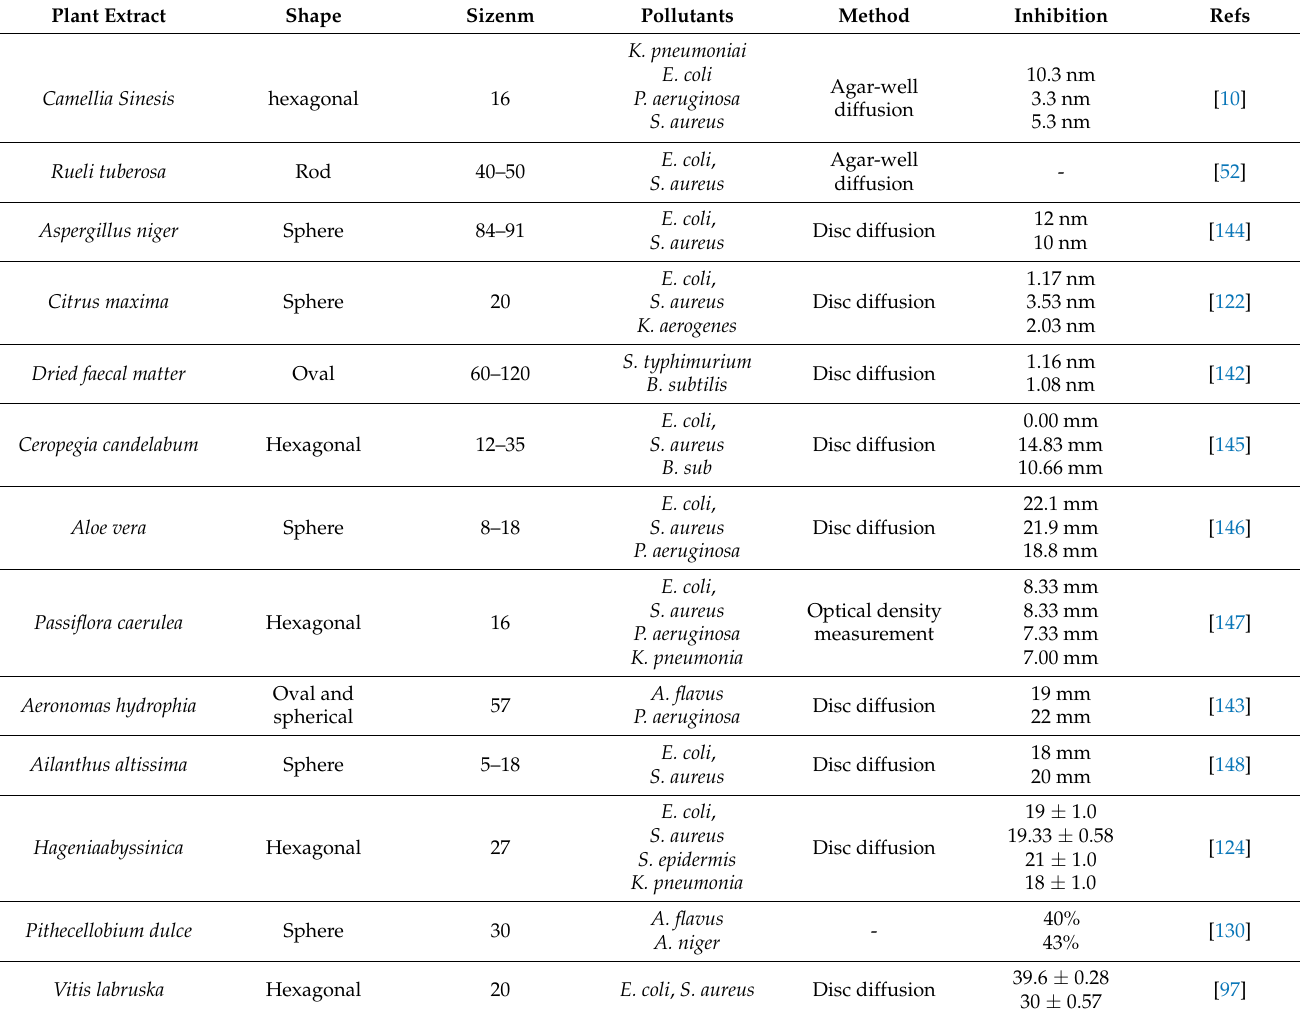
Table 5. Green ZnO NPs against natural